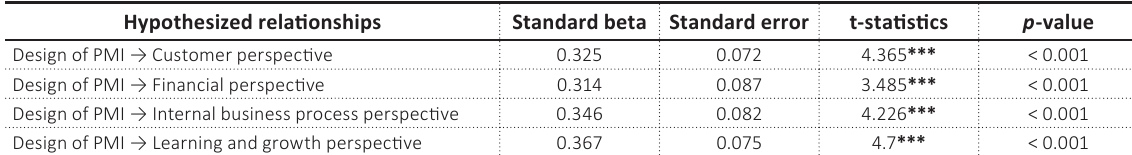
Figure 1. Final bootstrapped structural model showing the significance Table 4. Path coefficients for design and organizational outcomes